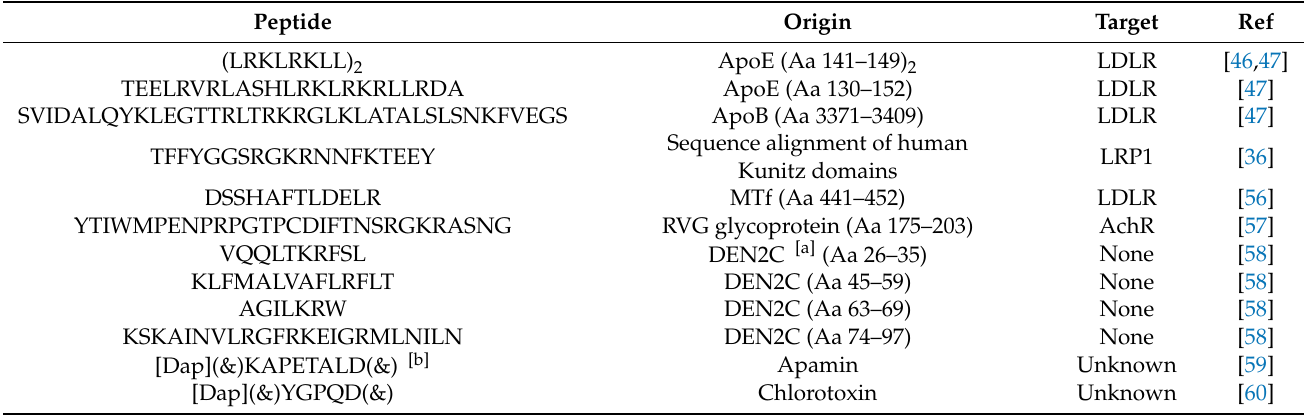
Table 1. Brain-targeting peptides obtained from natural